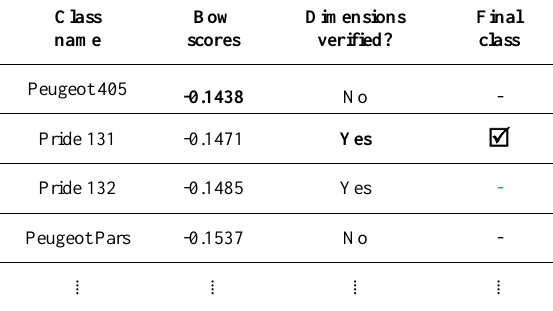
Table 3. Vehicle classification using BoW and